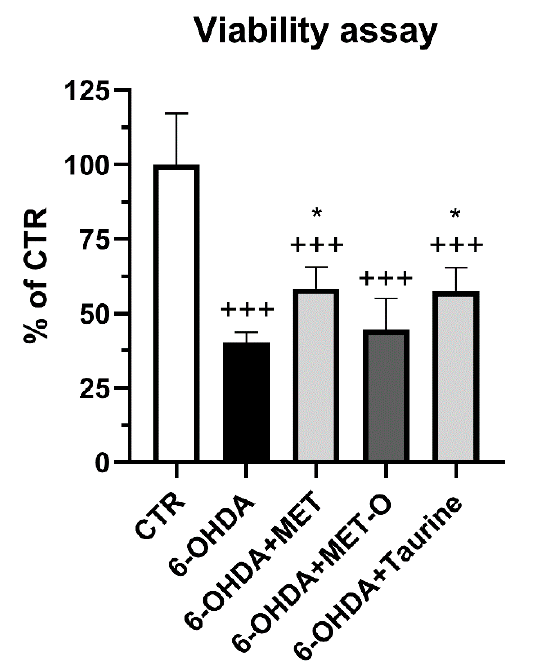
Figure 1. Cell viability assay for differentiated SH-SY5Y pretreated with Met or Met-O and taurine before 6-OHDA treatment. Data are mean ± SD of 3 different experiments. * p < 0.05 vs. 6-OHDA; +++ p < 0.0001 vs. control (CTR).